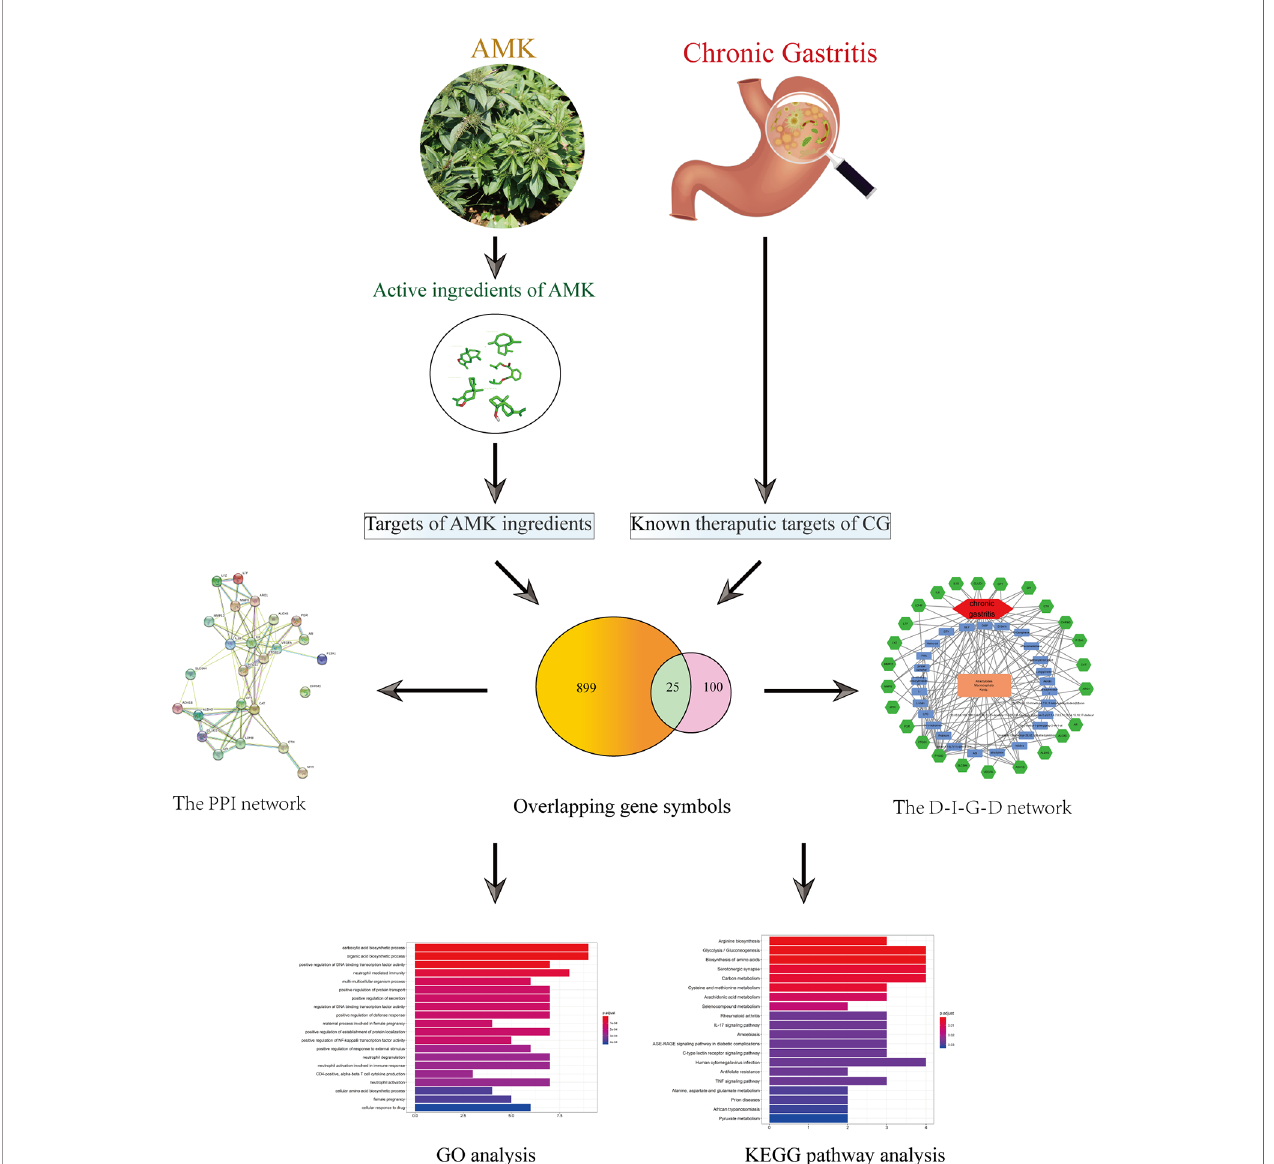
FIGURE 1 | Flowchart of a network pharmacology-based strategy to investigate the pharmacologic mechanisms of Atractylodes macrocephala Koidz. for treatment of chronic